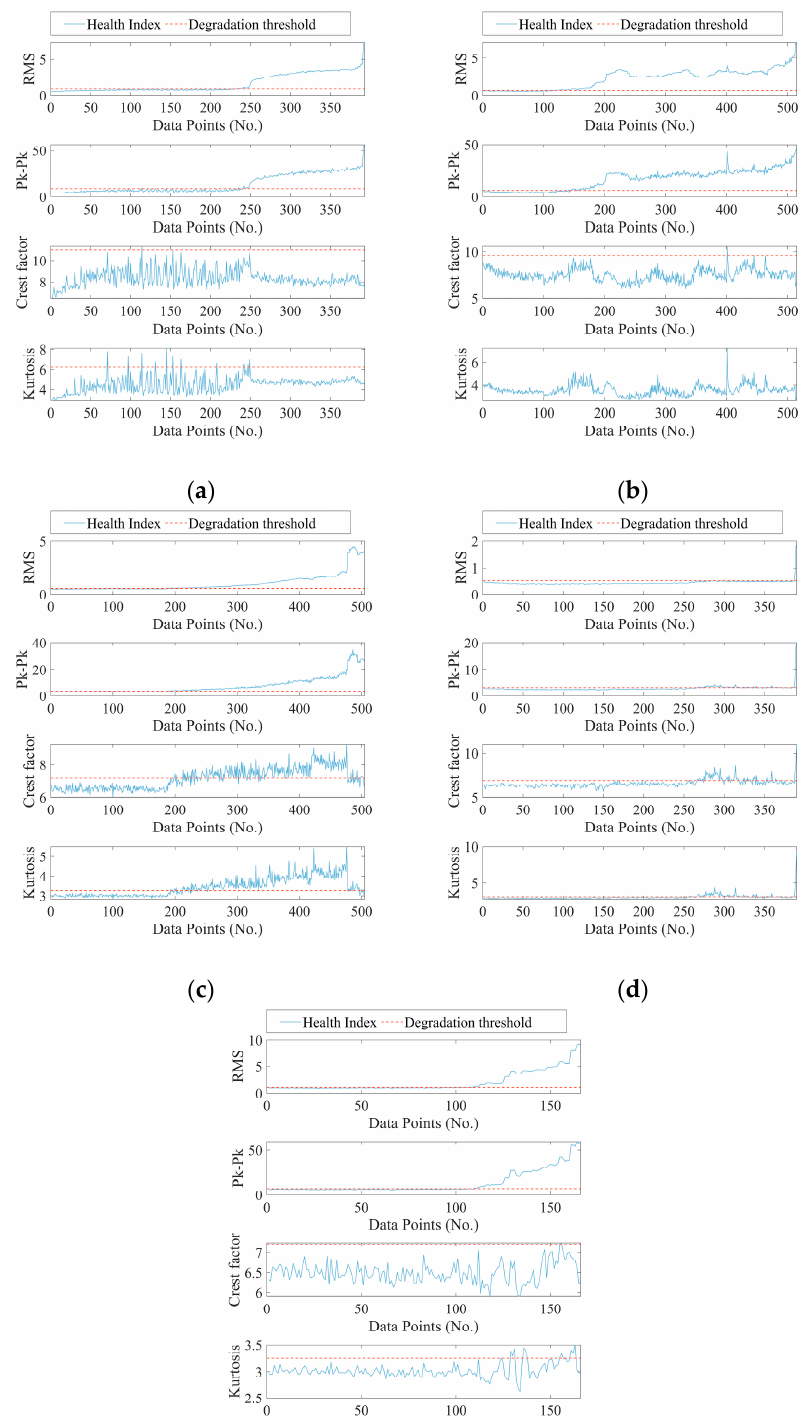
Figure 9. Results of early degradation detection using other healthy indexes: ( a ) Bearing 1_1, ( b ) Bearing 1_2, ( c ) Bearing 1_3, ( d ) Bearing 1_4, ( e ) Bearing 1_5. Four commonly used features are utilized to be compared with the proposed method. Methods of RMS and peak-to-peak value can achieve similar effectiveness on degradation trend, but it is not sensitive enough to weak degradation. Methods of crest factor and kurtosis are very easily influenced by fluctuation and are even unable to capture the correct degradation trend.